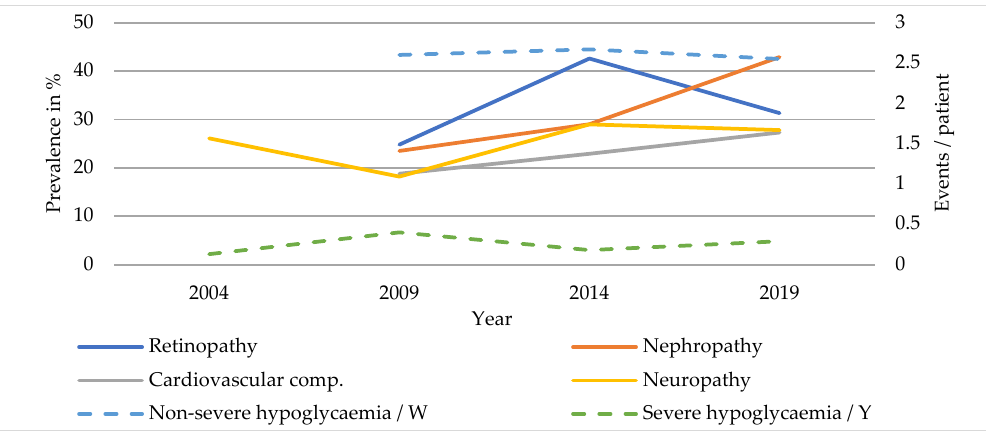
Figure 2. Diabetic complications of patients with T1DM in TC.